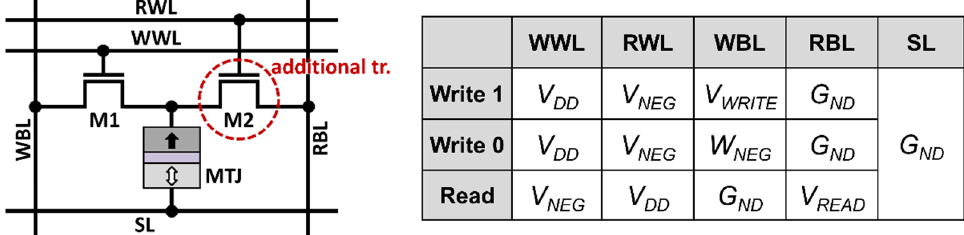
Figure 2. Dual 1R/1W STT-MRAM bit cell and biasing condition for write and read operations.